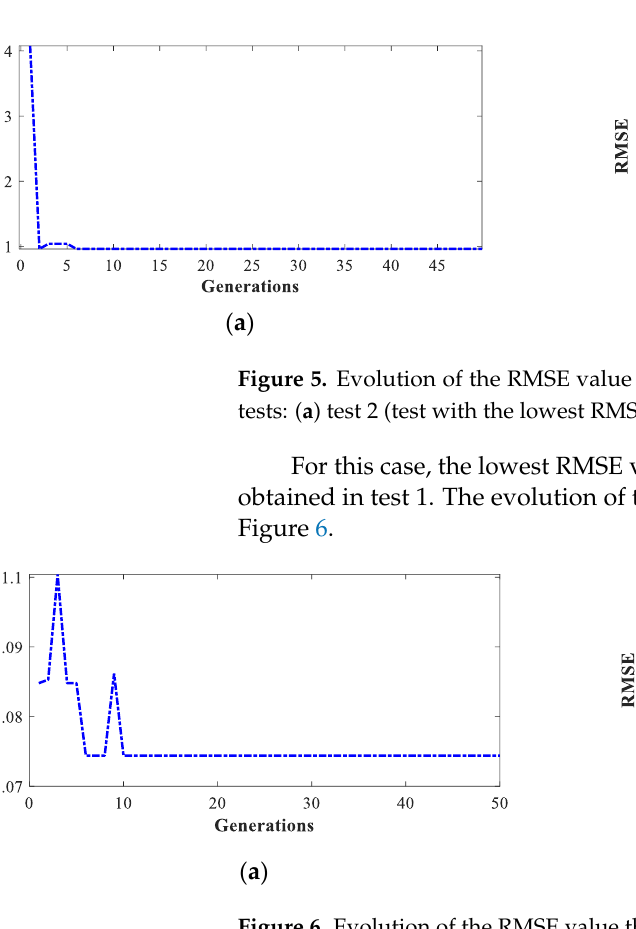
Figure 7. Estimated SOC obtained in the test using the second transmission shift: ( a ) test 2 (test with the lowest RMSE value) and ( b ) test 1 (test with the highest RMSE value).